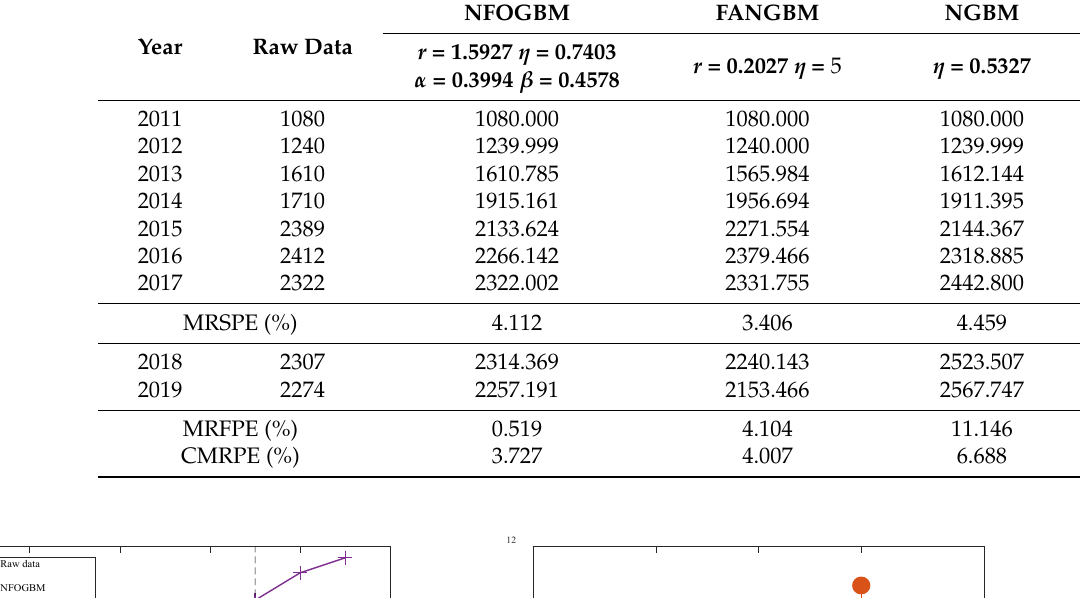
Table 7. Modeling results for CMD.